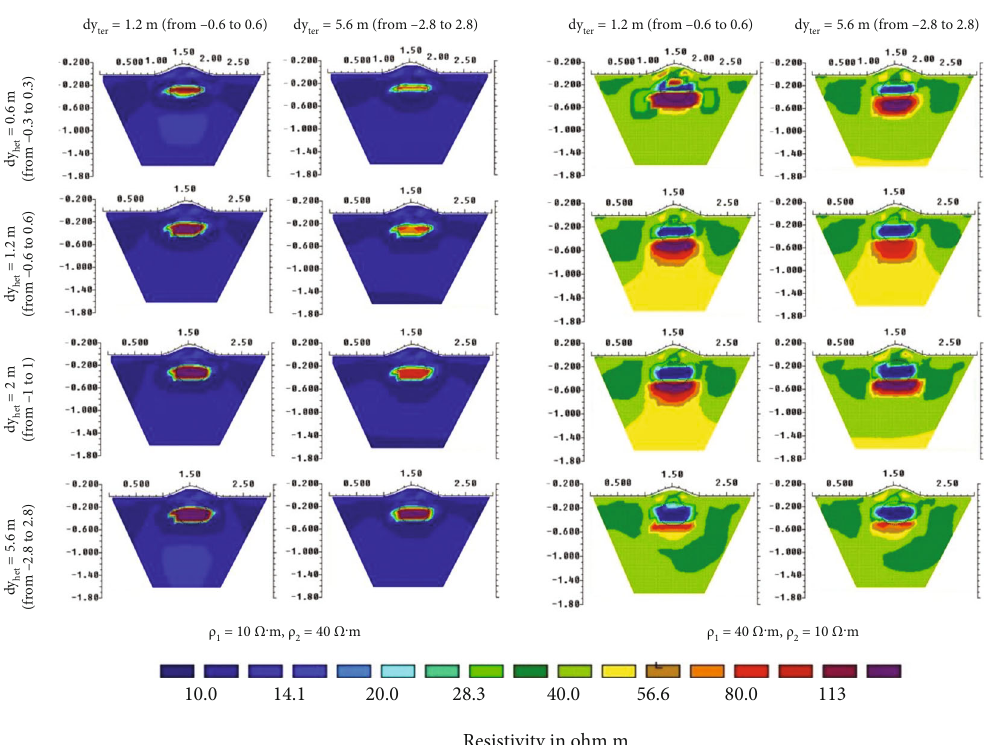
Figure 9: The in fl uence of the inhomogeneity ’ s size of a 3D medium with the ground surface topography in the Y-direction on the results of 2D